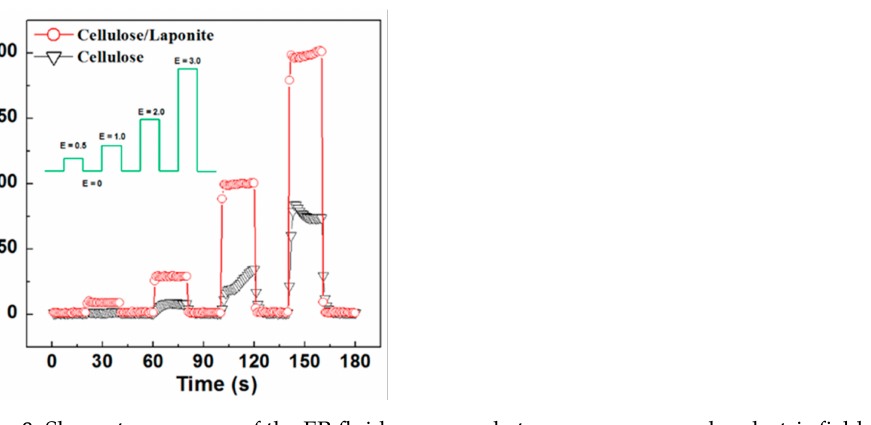
Figure 8. Shear stress curves of the ER fluids measured at a square-wave pulse electric field (shear rate: 1 s − 1 ; time of each period: 20 s; unit of E: kV/mm).